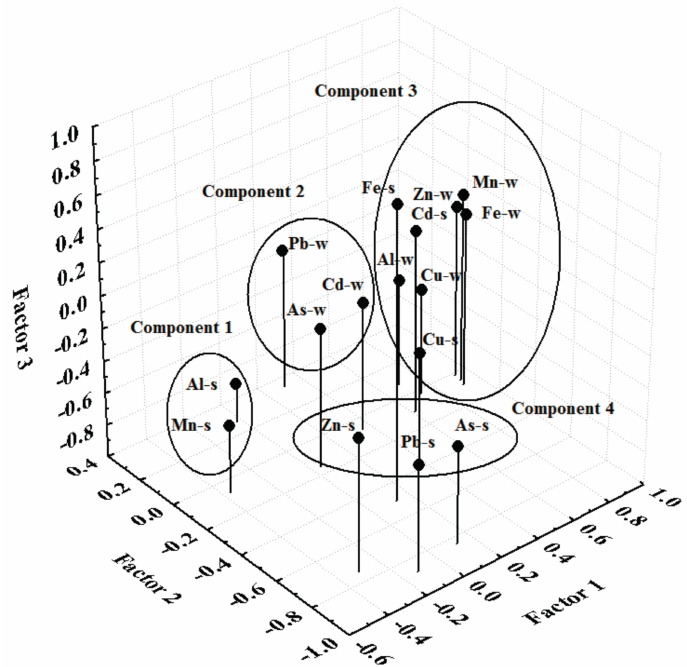
Figure 6. Graphical display of the principal components influencing the heavy metal concentration in sediment and water in sediment site 3.